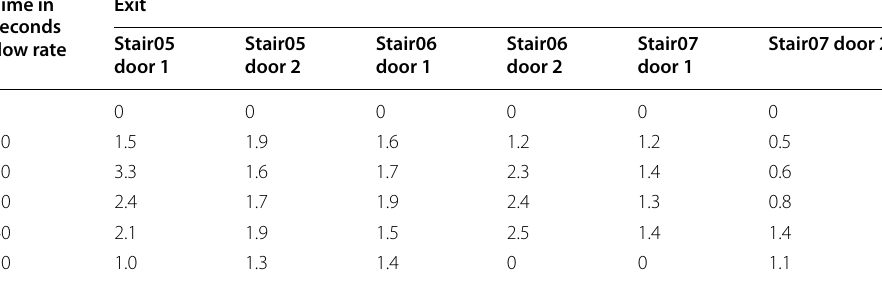
Table 2 Changes in the flow of people at each stairway and